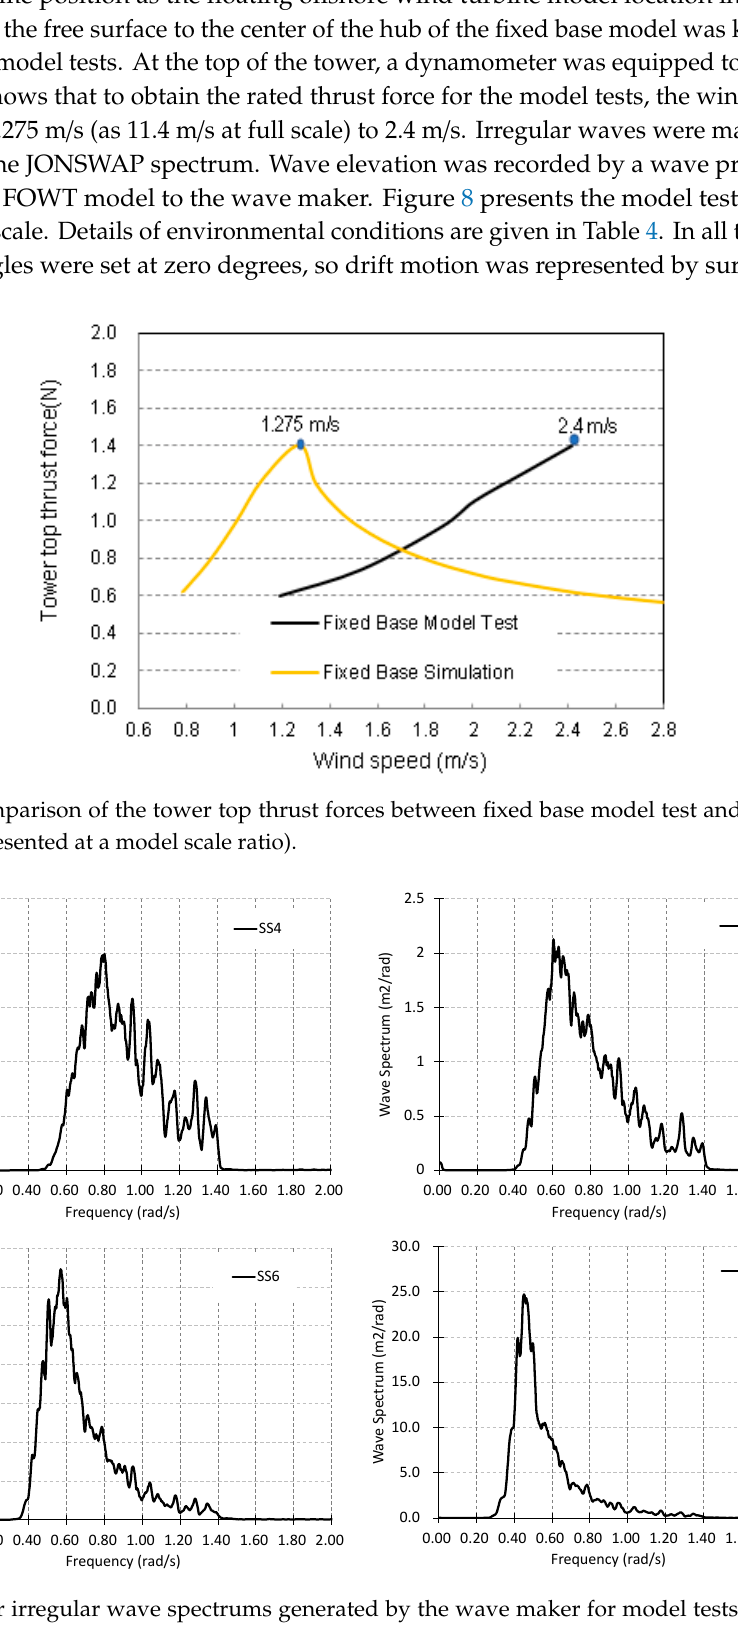
Table 4. Environmental conditions and wind turbine operational status of LC1 and LC2.